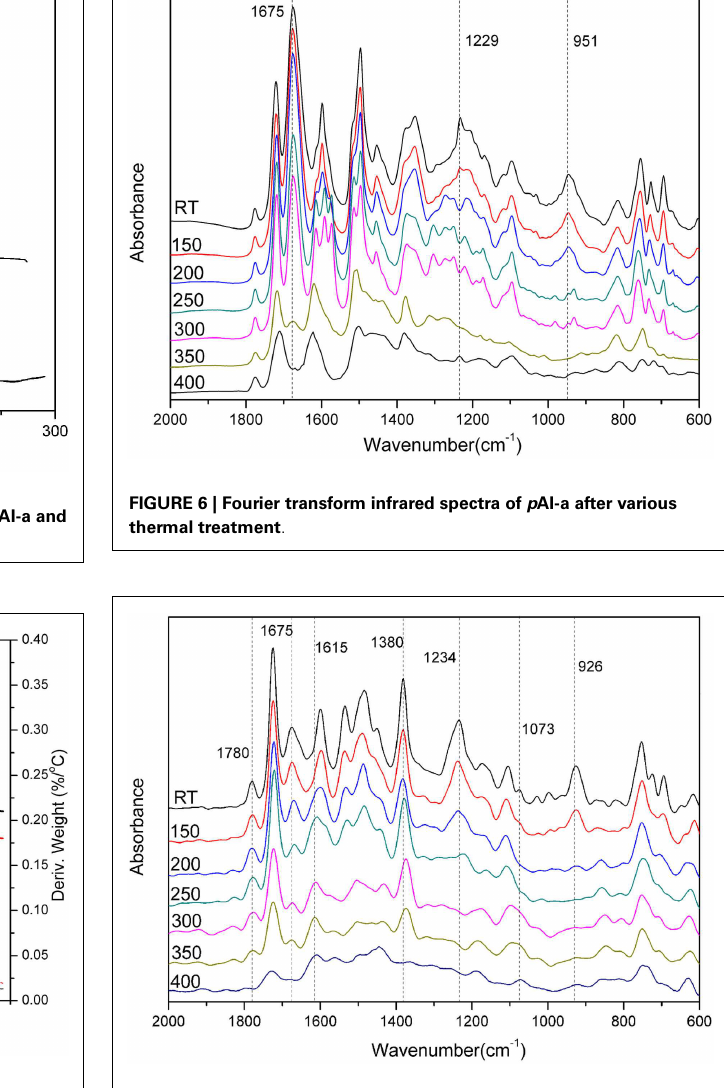
FIGURE 5 |Thermogravimetric analysis of amide-co-imide functional benzoxazine isomers after thermal polymerization at 200°C .